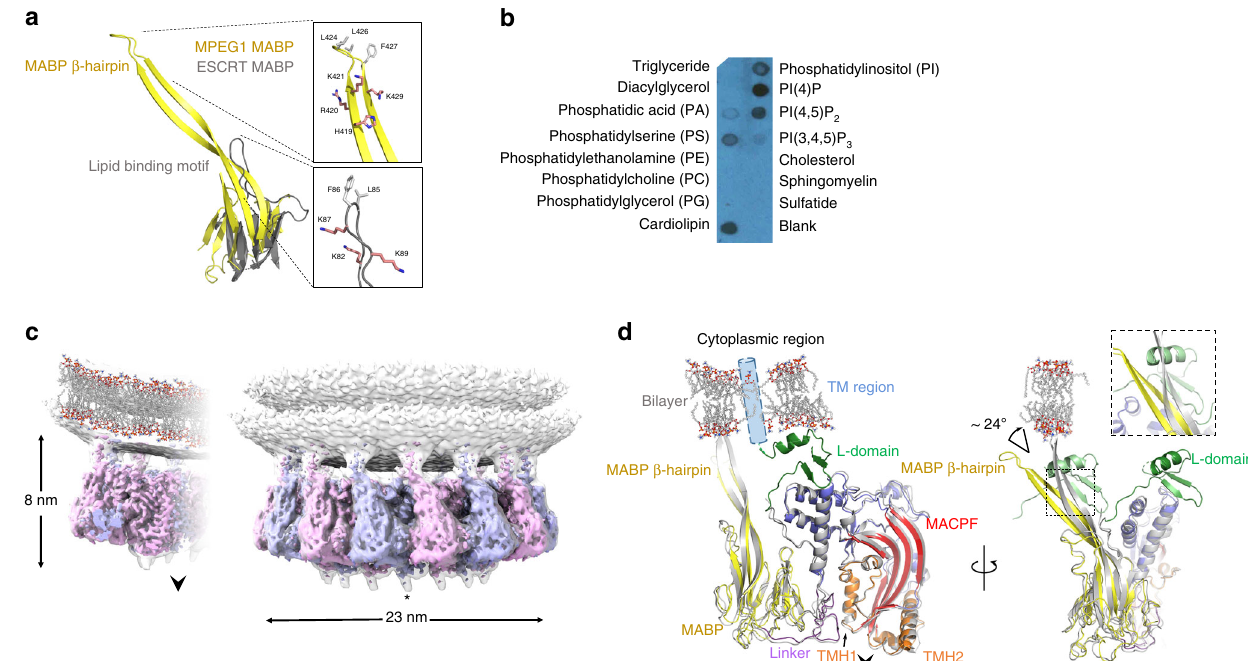
Fig. 2 MPEG1 interacts with negatively charged phospholipids via its MABP β -hairpin. a Structural superposition of the MPEG1 MABP domain (yellow) and the MVB12-associated β -prism (grey). The lipid-binding loop of the MVB12-associated β -prism maps to the MABP β -hairpin. The tip of both the MPEG1 β - hairpin and the MVB12 loop similarly contain a group of positively charged and hydrophobic residues. b MPEG1 displays broad speci fi city for lipids with negative charge. c 3.6 Å structure of MPEG1 bound to lipid membranes (subunits alternately coloured). A glycan moiety (indicated by an asterisk) is attached to TMH-2. The direction that the pore-forming β -hairpins are released to form a membrane spanning β -barrel is shown by an arrow. d Structural superposition of the MPEG1 monomer derived from the head-to-head assembly (coloured as in Fig. 1c), and the lipid bound form (grey). The predicted position of the transmembrane domain (absent in the structure) is shown (blue cylinder). The β -hairpin shifts ~24° in response to lipid interaction and the L-domain is disordered in the lipid bound form. The approximate position of the membrane is shown for reference